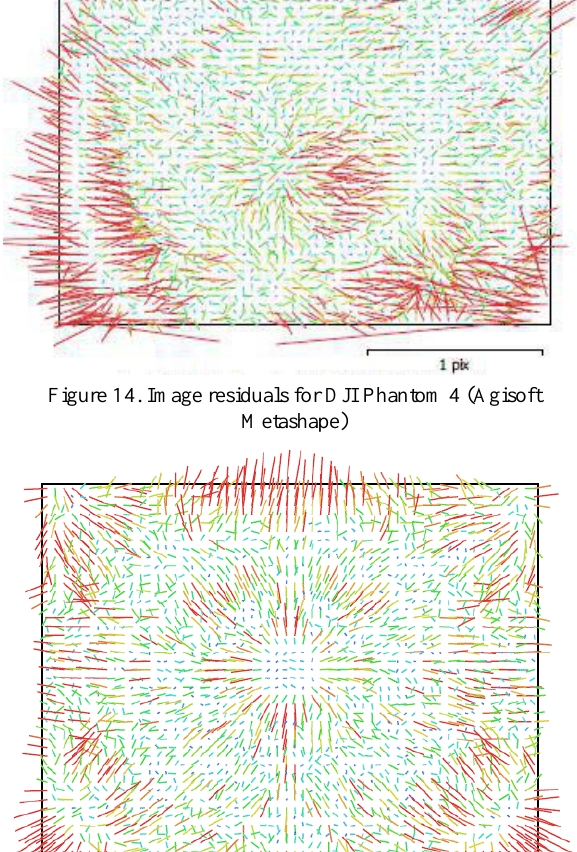
Table 4. Variations of principal distance for different flight